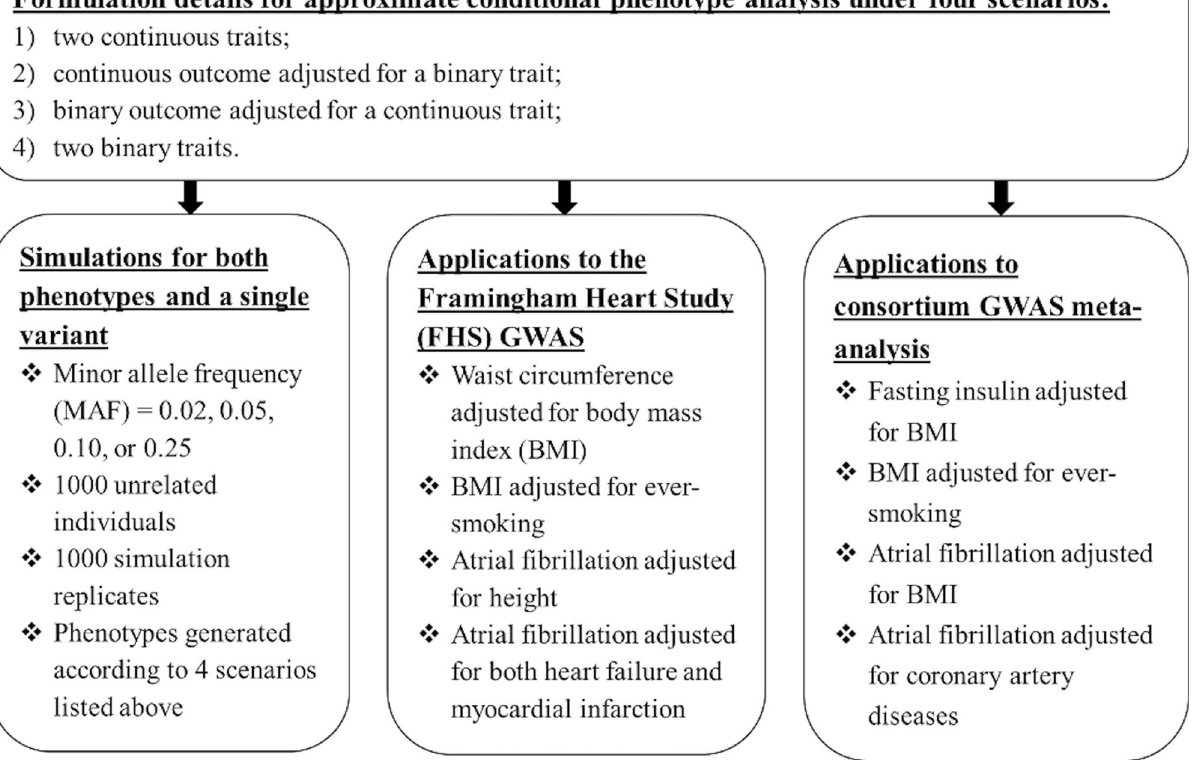
Figure 1. Framework for approximate conditional phenotype analysis